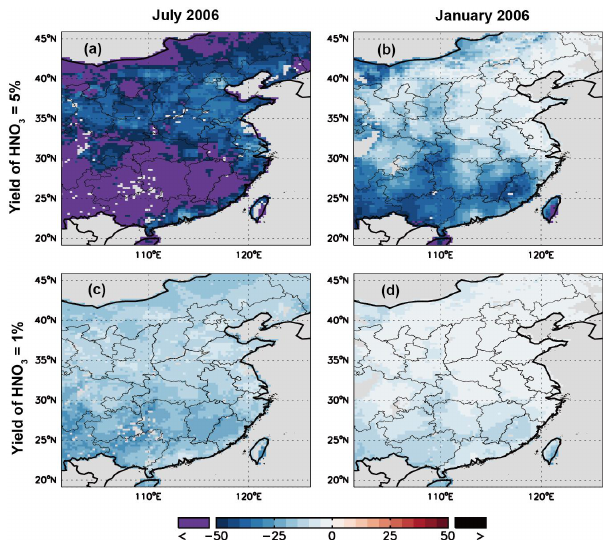
Fig. 8. Spatial distribution of percentage differences between mod- eled NO 2 columns with and without assuming a yield of HNO 3 at 5% (a, b) or 1% (c, d) from the HO 2 + NO reaction.